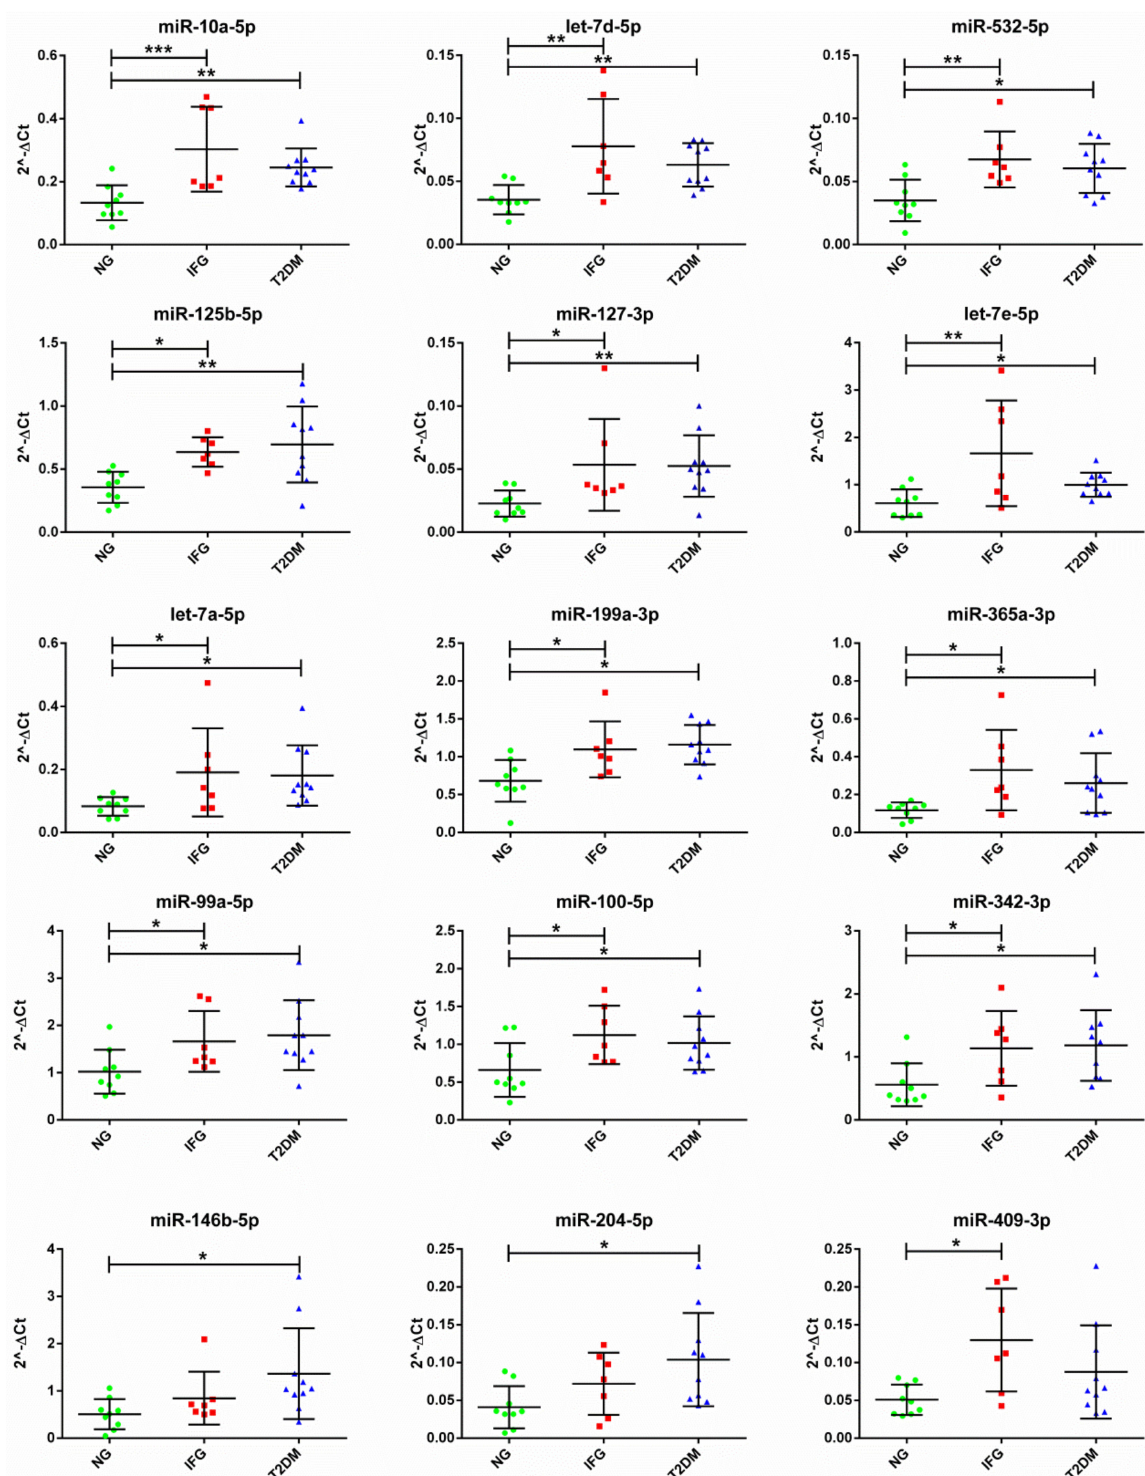
Figure 5. The expression profiles of 15 significantly changed miRNAs (FDR < 0.1) among T2DM, IFG and NG females (N = 26), based on one-way ANOVA and Tukey’s HSD post hoc test. Data was presented as dot plots with mean ± SD. Expression of the miRNAs was normalized to expression levels of miR-93-5p and miR-17-5p. Green dots, red squares and blue triangles represent results obtained for NG, IFG and T2DM females, respectively. (*) p ≤ 0.05; (**) p ≤ 0.01; (***) p ≤